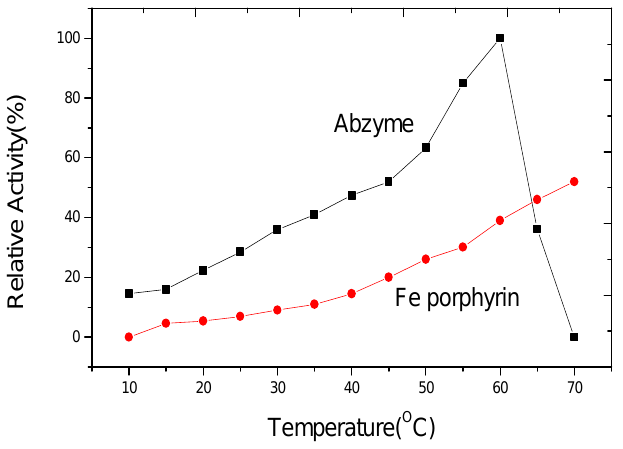
Figure 6. Temperature-activity curves for abzyme and Fe porphyrin.The chloroperoxidase activity of the MAb 1F2-Fe porphyrin complex was assayed at different temperatures varying between 10 °C and 70 °C and compared with that of Fe porphyrin.The concentration of monochlorodimedon is 0.3 O is 0.6 mM.Fe porphyrin (0.1 µ M) and abzyme (0.1 µ M) were mM.The concentrations of H 2 2